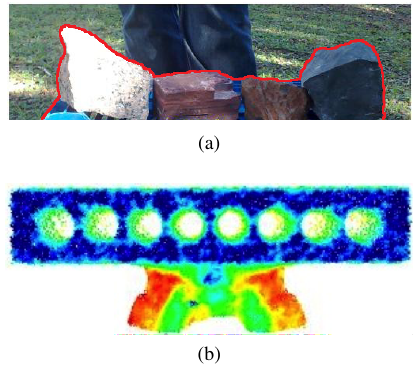
Figure 1: (a) The red area is the edge of the target where edge effect may appear. (b) The green points inside the circles and around the blue rectangle represent the edge effect seen in the 3D point cloud.